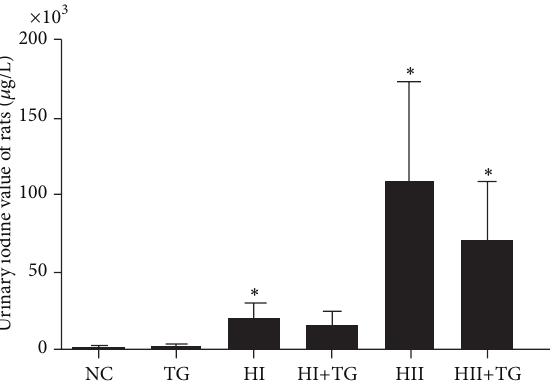
Figure 1: The bars in this figure show different urinary iodine values in each group of rats. ( 𝐹 = 44.428, 𝑃 < 0.05 ). Compared with the NC group, each group showed an increase in the urinary iodine value with increase in the iodine intake ( ∗ 𝑃 < 0.05 compared with the NC group).